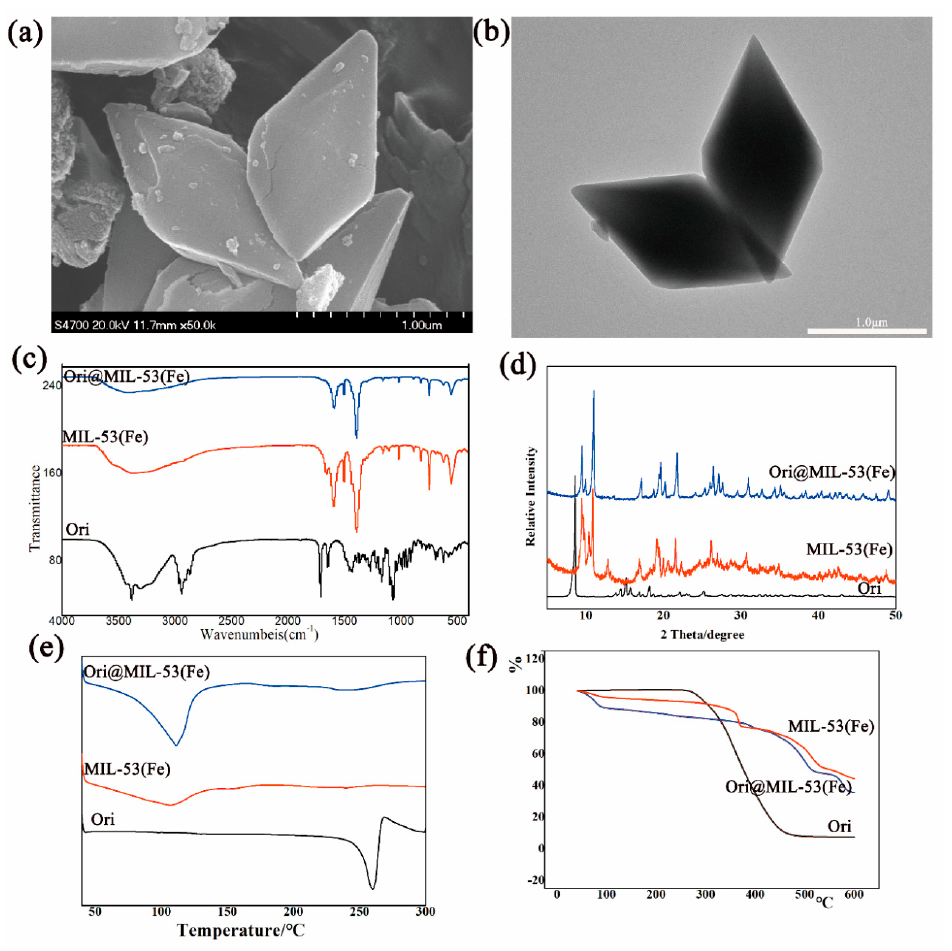
Figure 4. Characteristic of Ori@MIL-53(Fe): ( a ) SEM, ( b ) TEM, ( c ) FTIR, ( d ) XPRD, ( e ) DSC and ( f ) TGA.